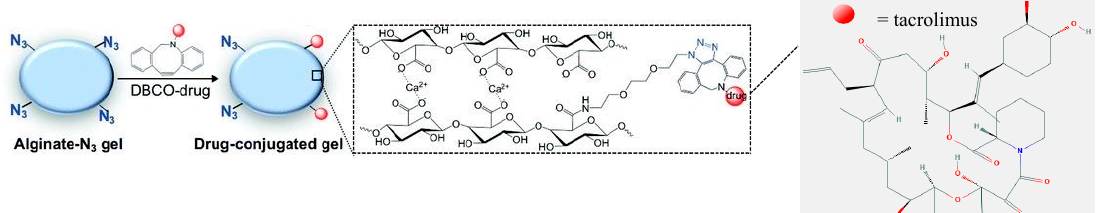
Figure 5. Schematic illustration of the binding of DBCO-drug (e.g., tacrolimus) prodrugs to the alginate-N3 gels. The schemes were extracted from reference [133]. PubChem Compound Summary for CID 445643, Tacrolimus. Retrieved 19 August 2020 from https://pubchem.ncbi.nlm.nih.gov/compound/Tacrolimus.